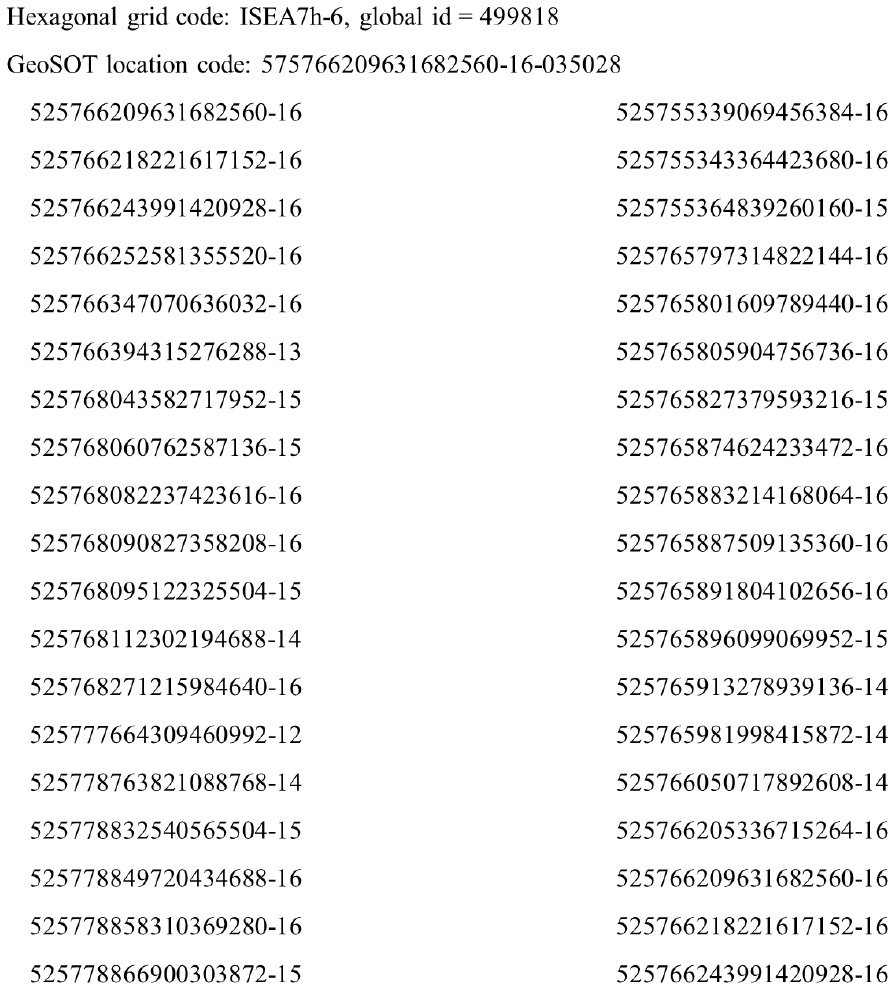
ISPRS Int. J. Geo-Inf. 2022 , 11 , x FOR PEER REVIEW